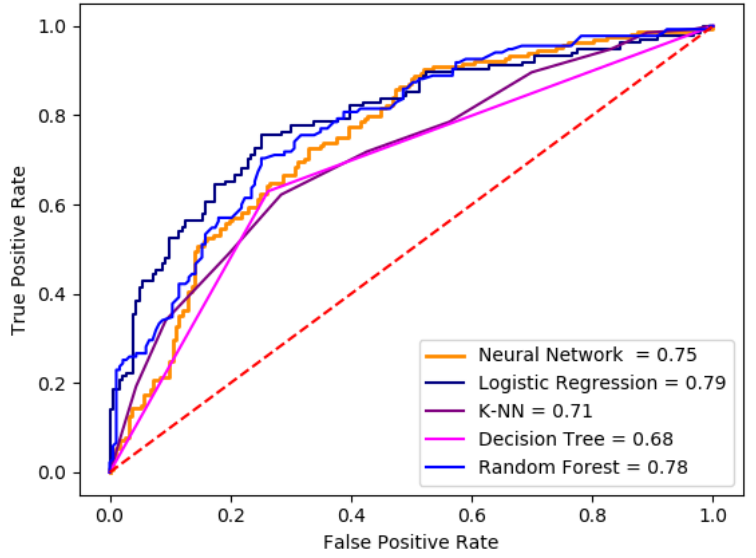
Figure 7. ROC curves obtained with the average performance of each implemented